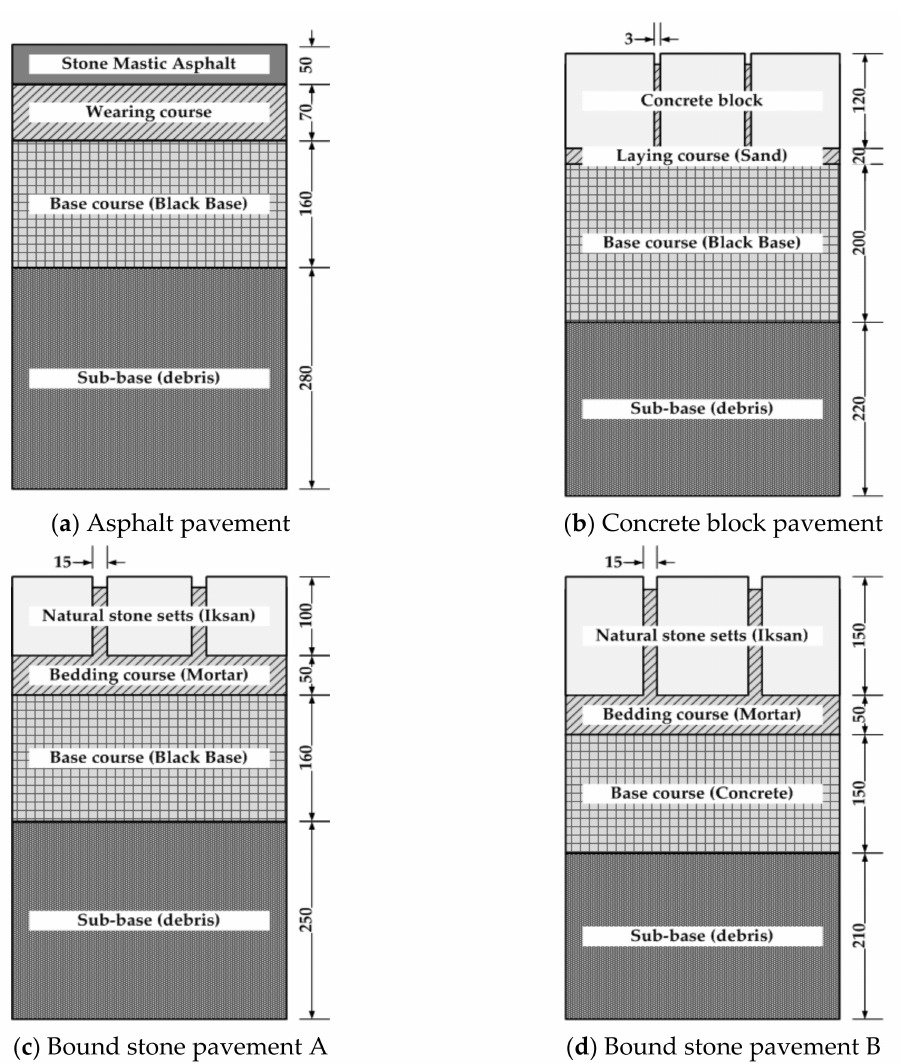
Figure 1. Pavement cross-sectional profiles for accelerated pavement